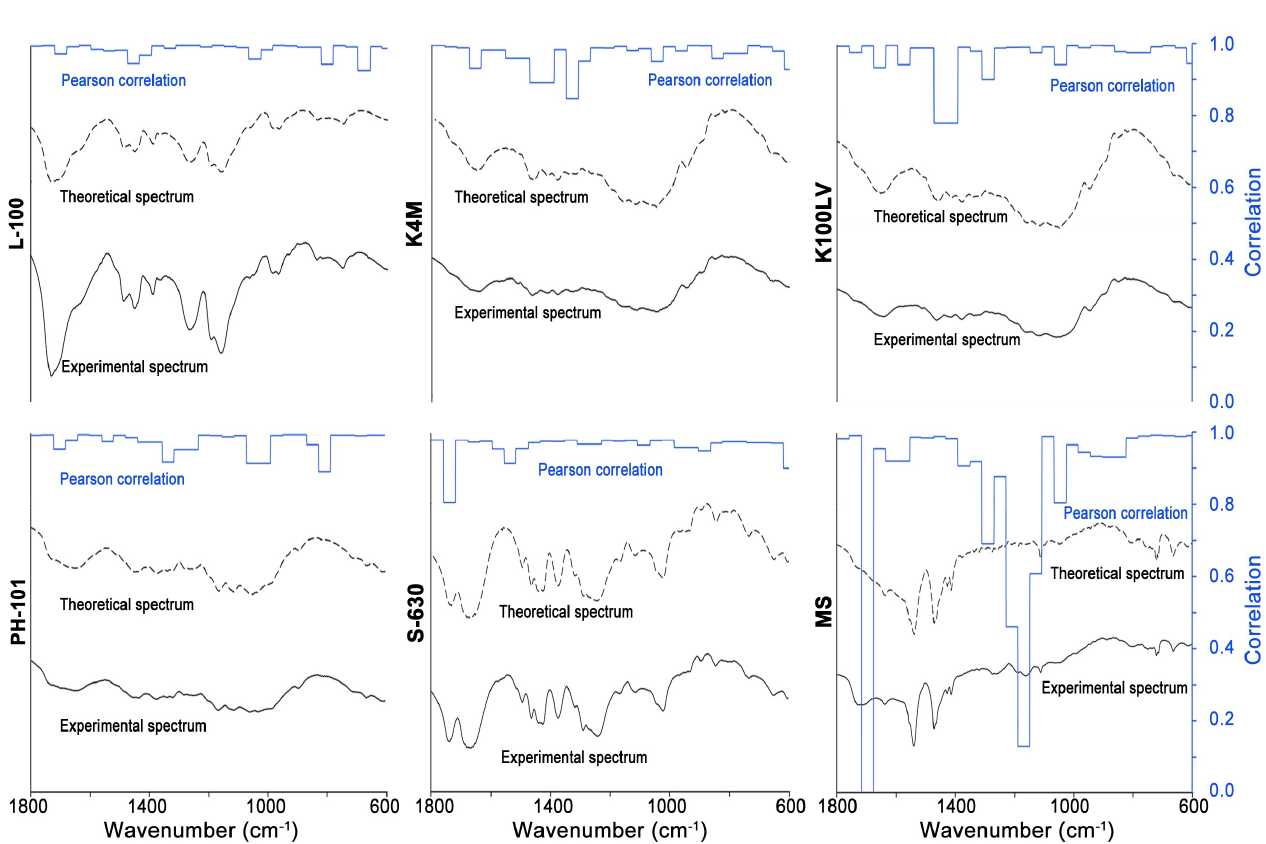
FIGURE 5 – Pearson correlation analysis of FTIR spectra for the binary mixtures of the bilberry leaf powder extract and the excipients: Eudragit L-100 (L-100), Methocel K4M (K4M), Methocel K100LV (K100LV), Avicel PH-101 (PH-101), Plasdone S-630 (S-630), and magnesium stearate